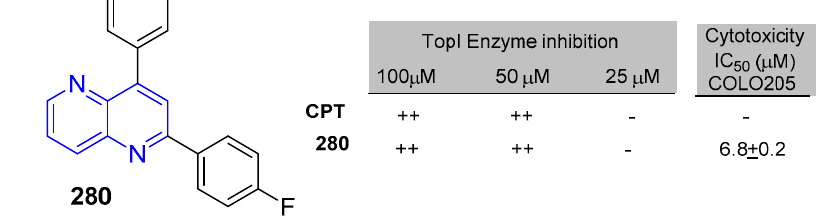
Figure 11. Inhibition of tankyrase activity.